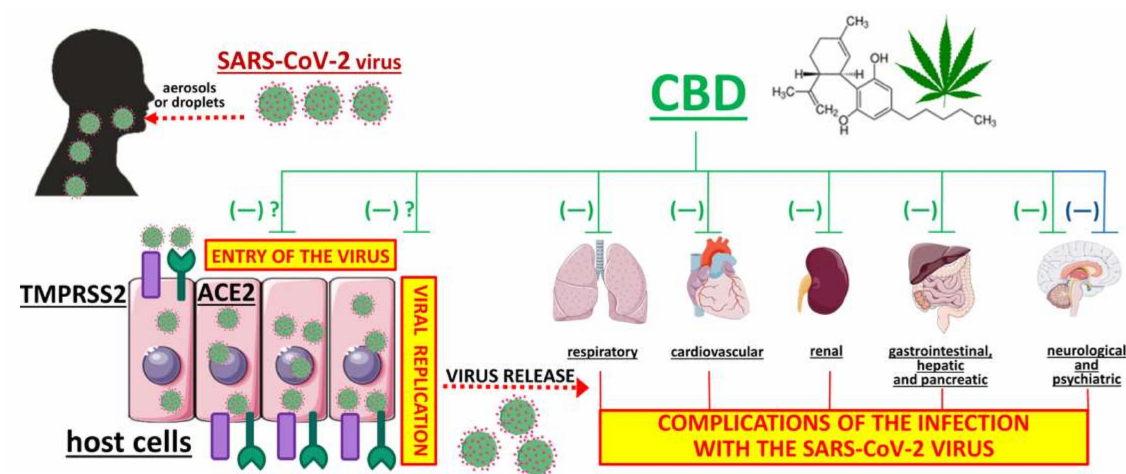
Figure 3. Potential therapeutic effect of cannabidiol against the SARS-CoV-2 virus infection. Three mechanisms have to be considered. The first and second mechanisms are the inhibitory effects on virus entry [67] and replication [68], respectively. These mechanisms have been described only recently and it is unclear whether they also occur in the human body. The third mechanism is a beneficial effect against complications which may also occur under a SARS-CoV-2 virus infection. In animal studies such a beneficial effect has been shown in five organ systems (green lines; Table 1) whereas in humans an effect on neurological and psychiatric disorders has been shown only (blue line; Table 2). ACE2, angiotensin-converting enzyme 2; CBD, cannabidiol; TMPRSS2, transmembrane serine protease